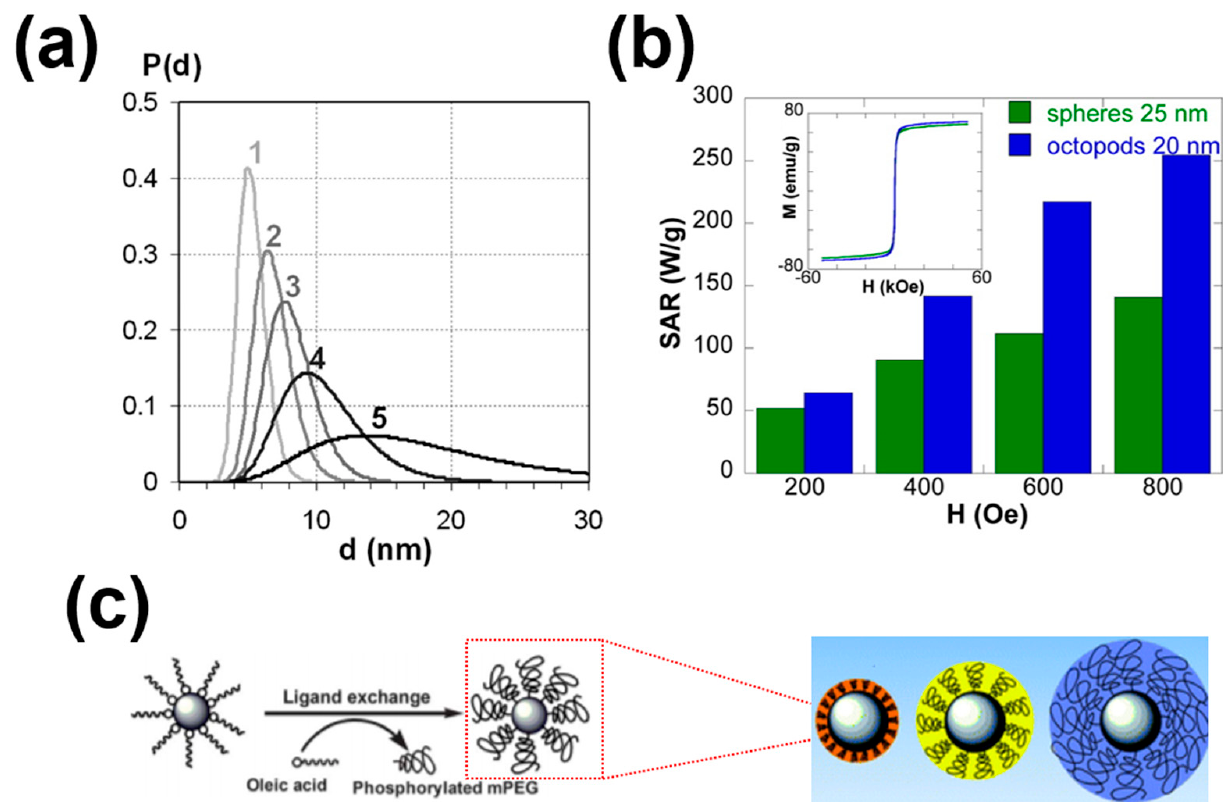
Figure 2. ( a ) Size distributions versus magnetization curves of five different samples Reprinted with permission from [68]. Copyright 2007 American Chemical Society. ( b ) SAR values for nano-octopods and spherical nanoparticles, and inset is the M–H loops at room temperature Reprinted with permission from [73]. Copyright 2016 American Chemical Society. ( c ) A schematic diagram of magnetic cores with different molecular weights of PEG coating. Reprinted with permission from [90]. Copyright 2012 The Royal Society of Chemistry. Table 2. Commonly used polymers for magnetic nanoparticle coating.